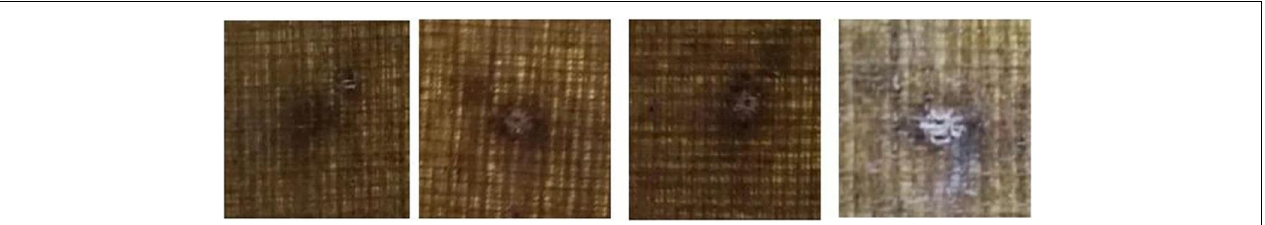
FIGURE 6 | Lightning defect of the flax reinforcement fiber.